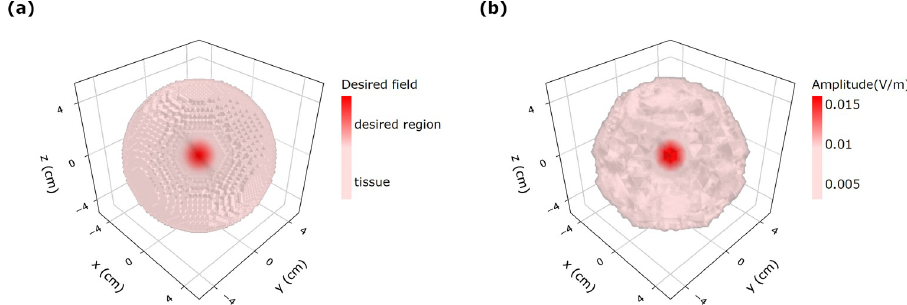
Fig 5. (a) Desired and (b) optimal electric fields with 64 magnetic dipoles at 1 GHz for brain material. The radius of the sphere 5 cm and the target point is x = y = z = 0 with a 1 cm spherical spot